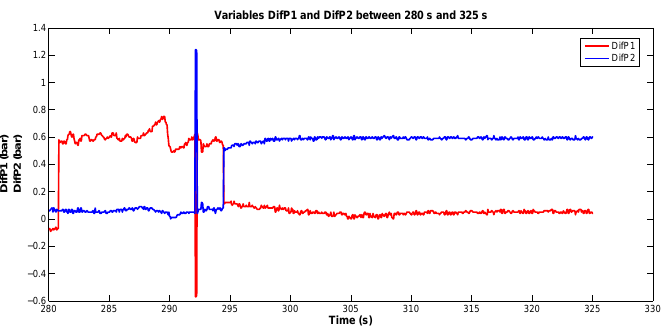
Figure 13. Variables DifP1 and DifP2 between 280 s and 325 s. Source: By Authors.